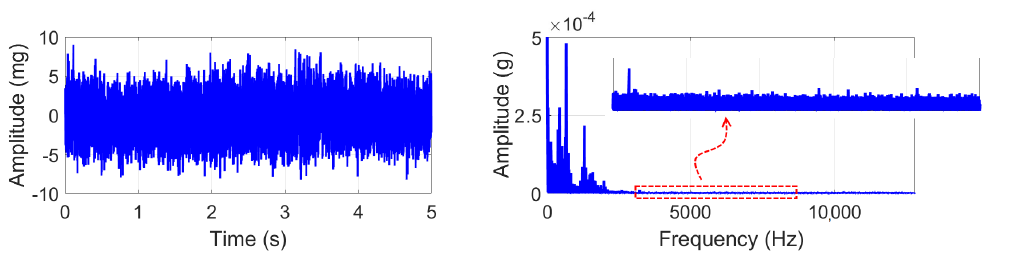
Figure 7. A section of tower vibration in parked condition: ( left ) time domain; ( right ) frequency domain—zoomed-in area is highlighted in red.